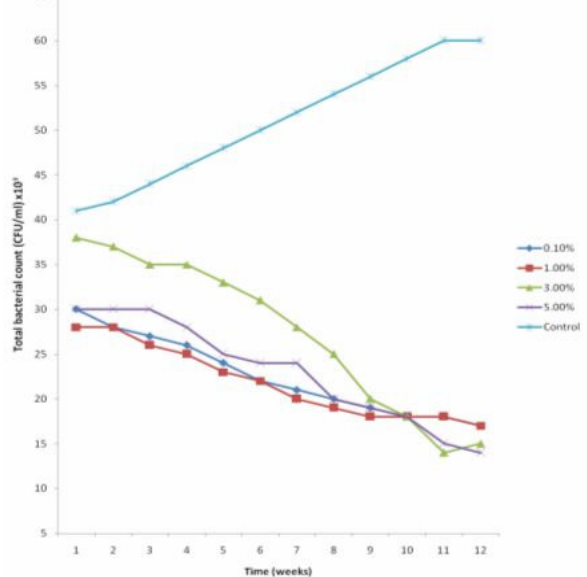
Fig. 2. Changes in the total bacterial counts of varying concentrations of sodium acetate preserved powder of mango seed kernels stored at room temperature for 12 weeks